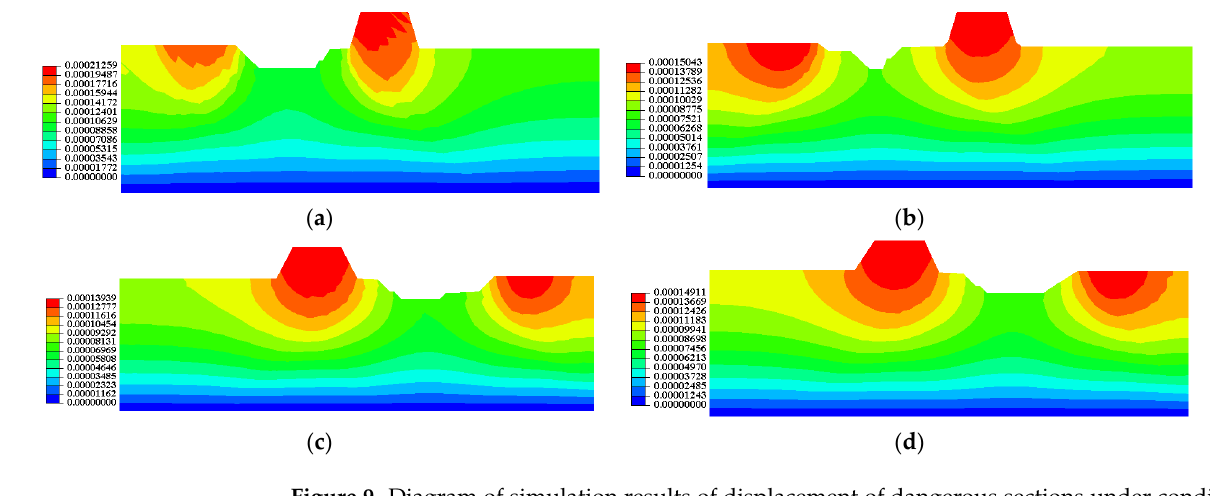
10 of 14 Figure 8. Numerical models of dangerous sections. ( a ) Section B–B; ( b ) Section E–E; ( c ) Section H– H; ( d ) Section J–J. 5.2. Stability Analysis In the ABAQUS software, the X -axis is generally regarded as 1-axis, Y -axis as 2-axis and Z -axis as 3-axis. S22 then represents the stress in the Y -axis direction, the positive value is tensile stress and the negative value is compressive stress. Under different water content conditions, the soil sites mainly undergo downward deformation. Therefore, in this study, the stress changes in Y direction (longitudinal direction) are mainly analyzed. Figure 9 shows the diagram of the simulation results of displacement obtained from the numerical simulation of the four dangerous sections of the trench under condition 1. Fig- ure 10 shows the diagram of the simulation results of longitudinal stress of the dangerous sections under condition 1. Given the assumption of condition 1, there is displacement at the top of the city wall and at the bottom of the trench, and the bank of the trench is large, with the earthen soil on the side facade tending to peel off. As a result, damage in the near future is not expected. However, when the external environment changes, the site soil will also deteriorate slowly, especially with the undercutting at the base being more serious and the displacement at the base generally being larger than that in the upper area. Figure 11 shows the diagram of the simulation results of displacement of the dangerous sections under condition 2. Figure 12 shows the diagram of the simulation results of longitudinal